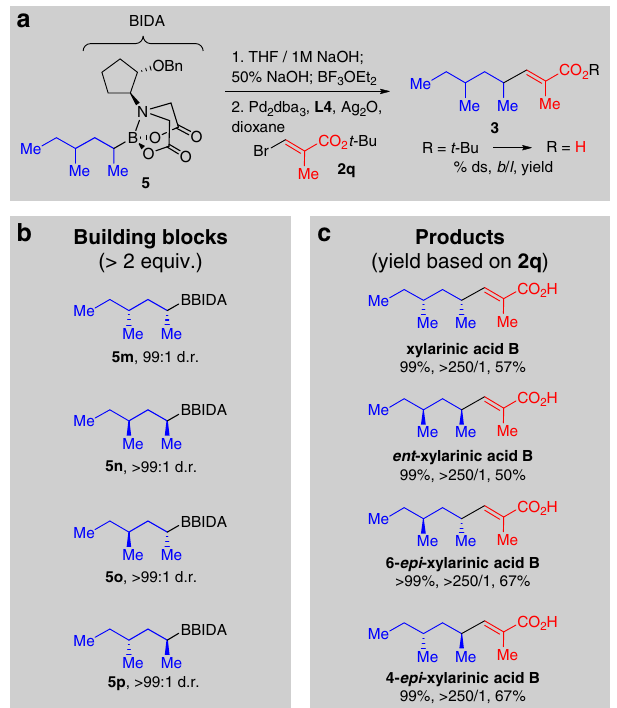
Fig. 5 Building block-based synthesis of all possible Csp 3 stereoisomers of xylarinic acid B. a Conditions for deprotection and coupling. b Air-stable BIDA boronate building blocks prepared by resolution. c Xylarinic acid B and all possible Csp 3 steroisomers accessed by stereospeci fi c cross- coupling of stereode fi ned building blocks. % ds, b / l , and yield refer to the cross-coupling